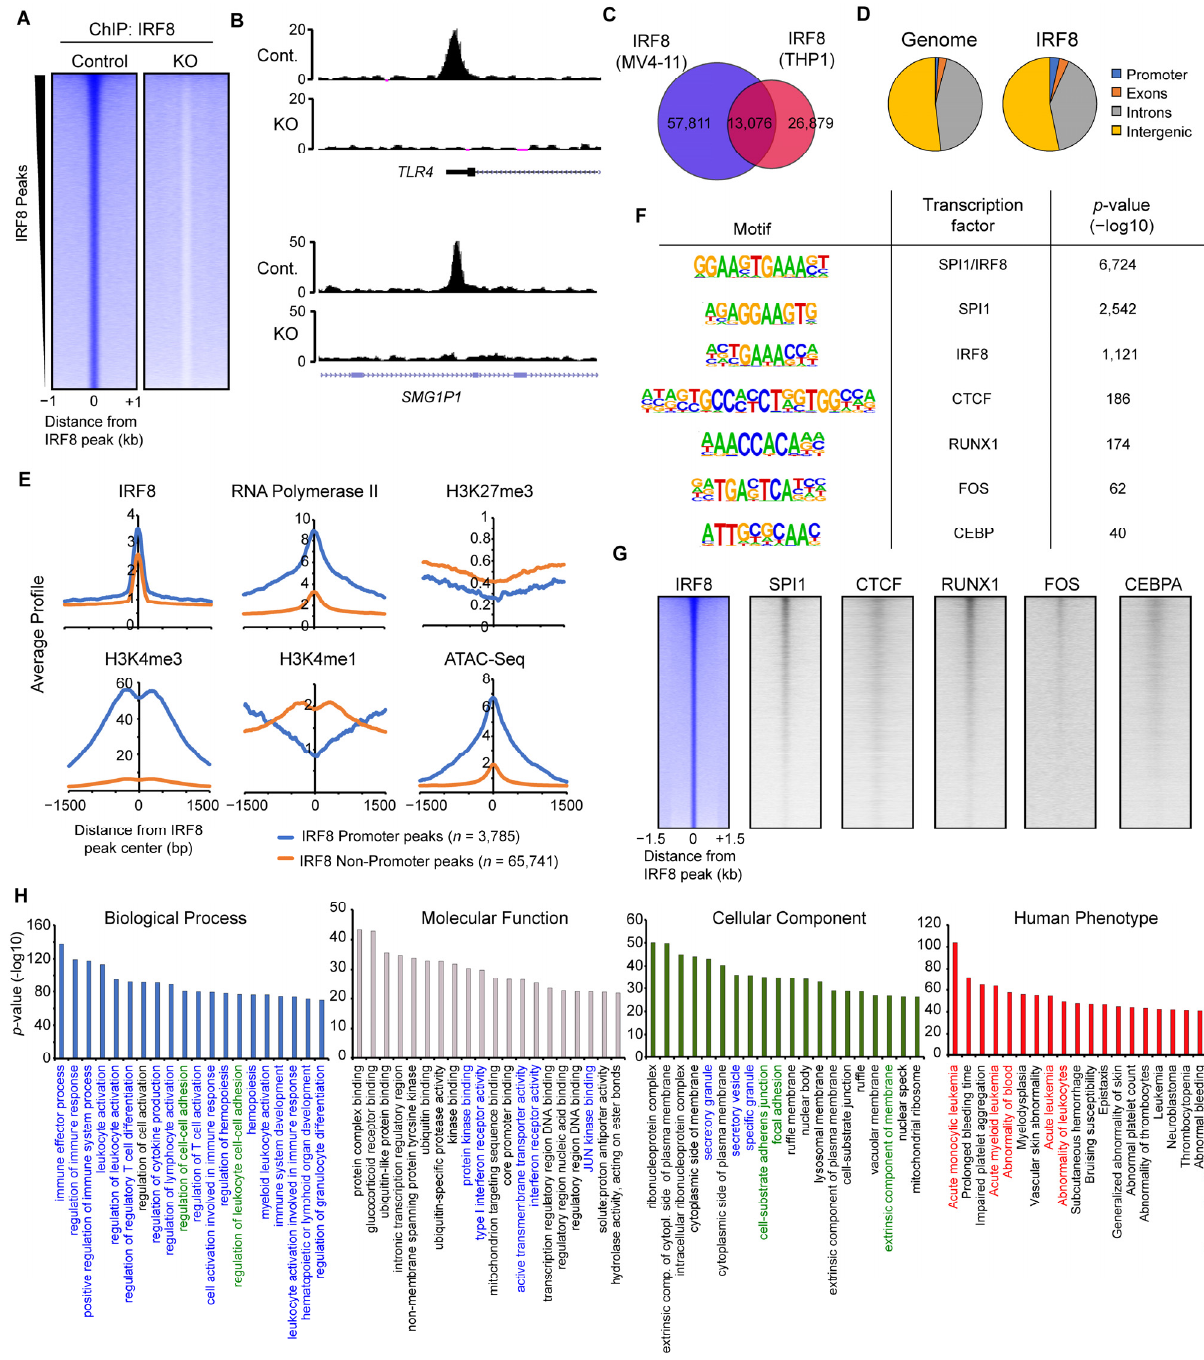
Figure 4. IRF8 binds to thousands of genomic loci in MV4-11 cells. ( A ) Heatmap of significant IRF8 peaks in Control and IRF8 knockout cells. ( B ) Genome browser view of two IRF8 peaks, at the TLR4 promoter and at an enhancer of SMG1P1. ( C ) Venn diagram showing the overlap of IRF8 ChIP-Seq results from MV4-11 cells and THP1 cells [29] . ( D ) Genomic distribution of IRF8 in MV4-11 cells, in comparison to the genome. ( E ) Histone modifications and RNA-Polymerase II at promoter or non-promoter IRF8 peaks. ( F ) Enriched motifs identified at IRF8 peaks. ( G ) Heatmaps showing the comparison of IRF8 with other transcription factors. ( H ) Gene ontologies associated with IRF8 target loci, identified using Genomic Regions Enrichment of Annotations Tool (GREAT) [33] . Colorized ontologies are related to immune response pathways (blue), cell adhesion pathways (green) and disease ontologies associated with leukemia (red). Investigation of the IRF8 binding pattern within the MV4-11 genome (Figure 4D) re- vealed that IRF8 is slightly enriched at promoter regions, but it is mostly present at non-